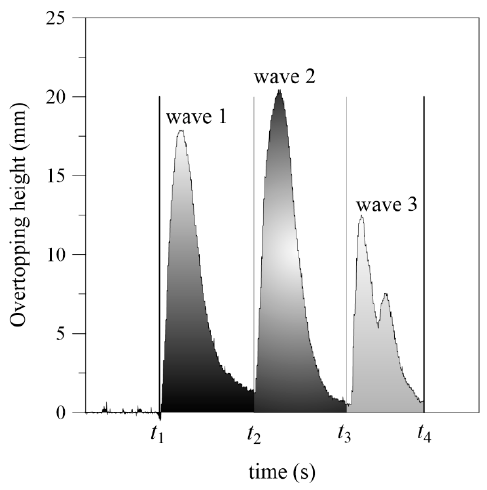
Figure 6. Overtopping height (mm) vs. time (s) plot for Q max calculation considering the three maximum waves recorded in channel (CH) 11.